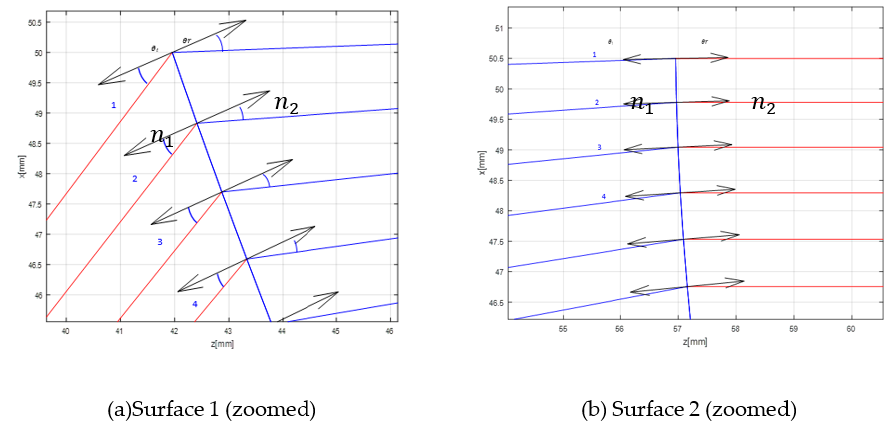
Figure 11. Rays in and rays out. Table 5. Calculated n